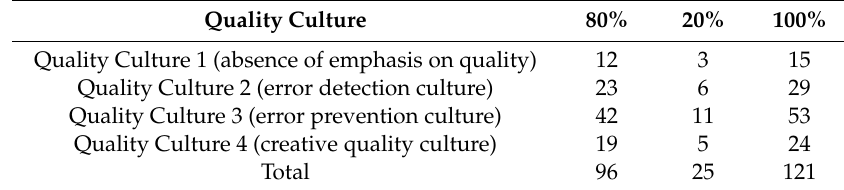
Table A3. Stratified dividing of the